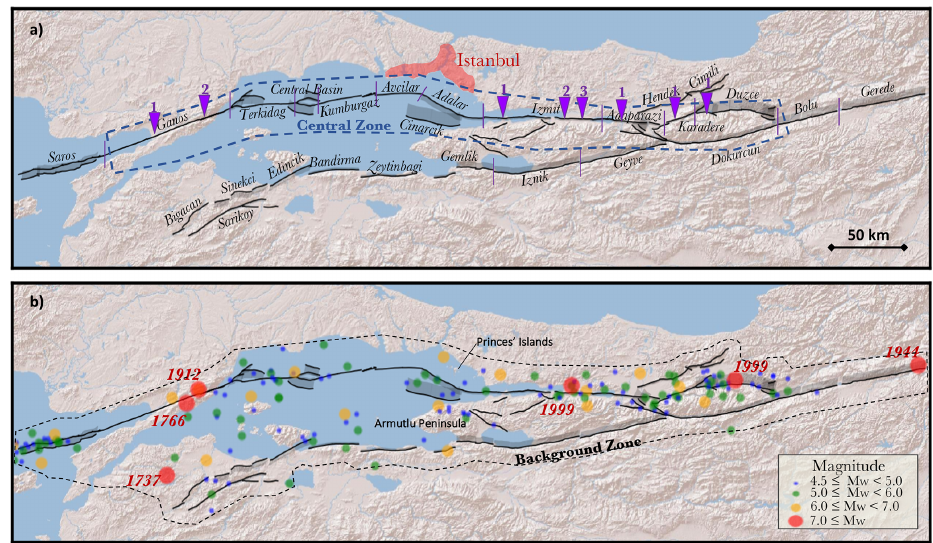
Figure 2. Fault system and the earthquake catalogue used in this study (Emre et al., 2018). (a) The fault sections are delimited by the purple lines, and the names of the fault sections are indicated in black. The purple triangles indicate the locations of palaeoseismic studies, and the numbers refer to the references of the specified fault section listed in Table 3. (b) Earthquakes of magnitude greater than magnitude 4.5 and during the complete period (see Table 2) in the Marmara Region. The years of occurrence of the largest earthquakes ( M > 7) are